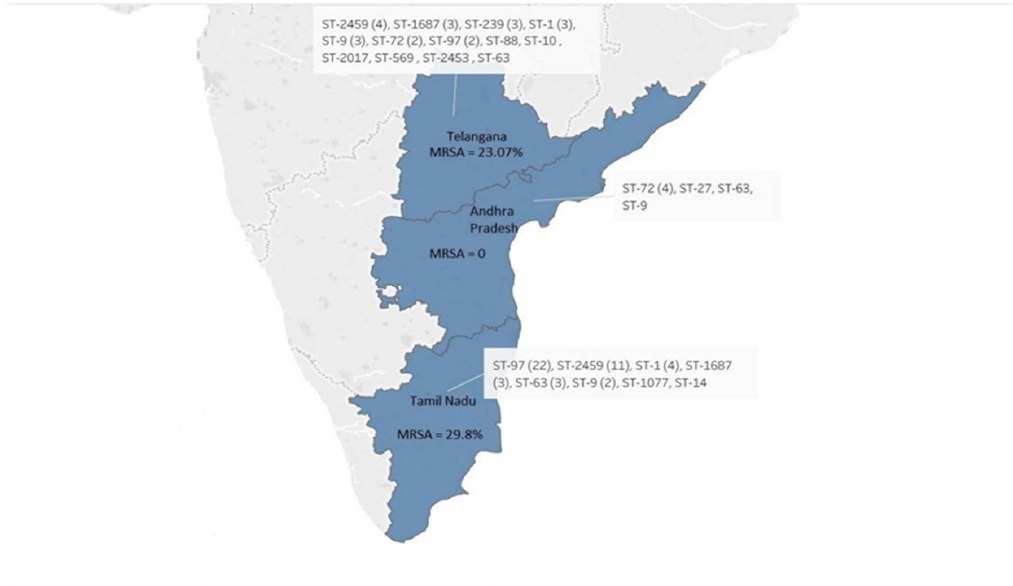
Figure 1. Distribution of sequence types (ST) of 80 clinical isolates of S. aureus and prevalence of MRSA among three different states: Telangana, Andhra Pradesh and Tamil Nadu. ST was determined using the multilocus sequence typing (MLST) method.